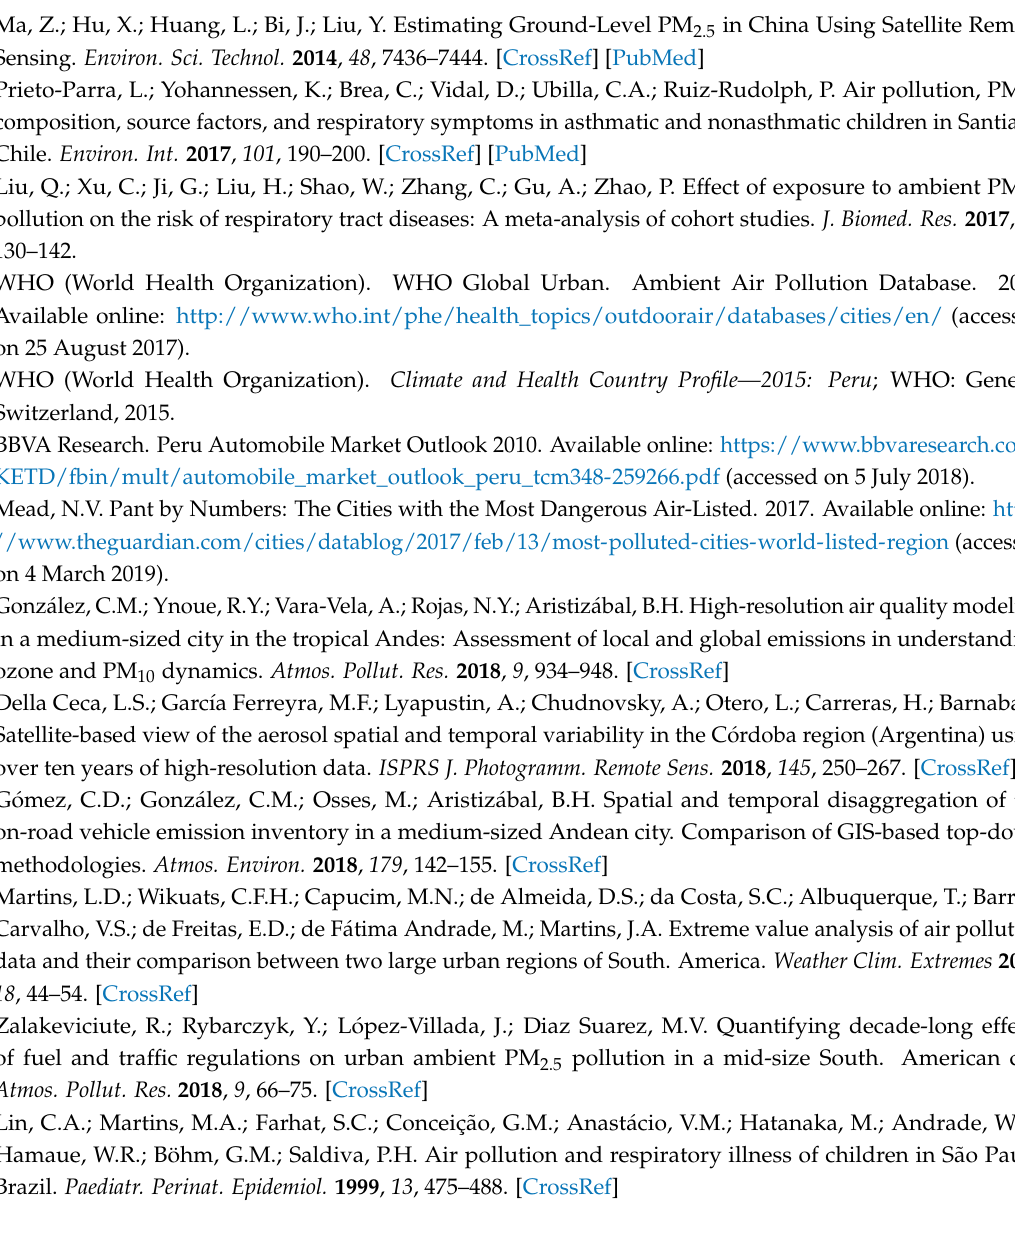
Figure S1: Simple Correlation Matrix between Weather Underground temperature and relative humidity with WRF-Chem temperature and ECMWF relative humidity, Figure S2: Histograms of each predictor variable, Figure S3: Monthly mean prediction maps of PM 2.5 concentrations in µ g/m 3 for